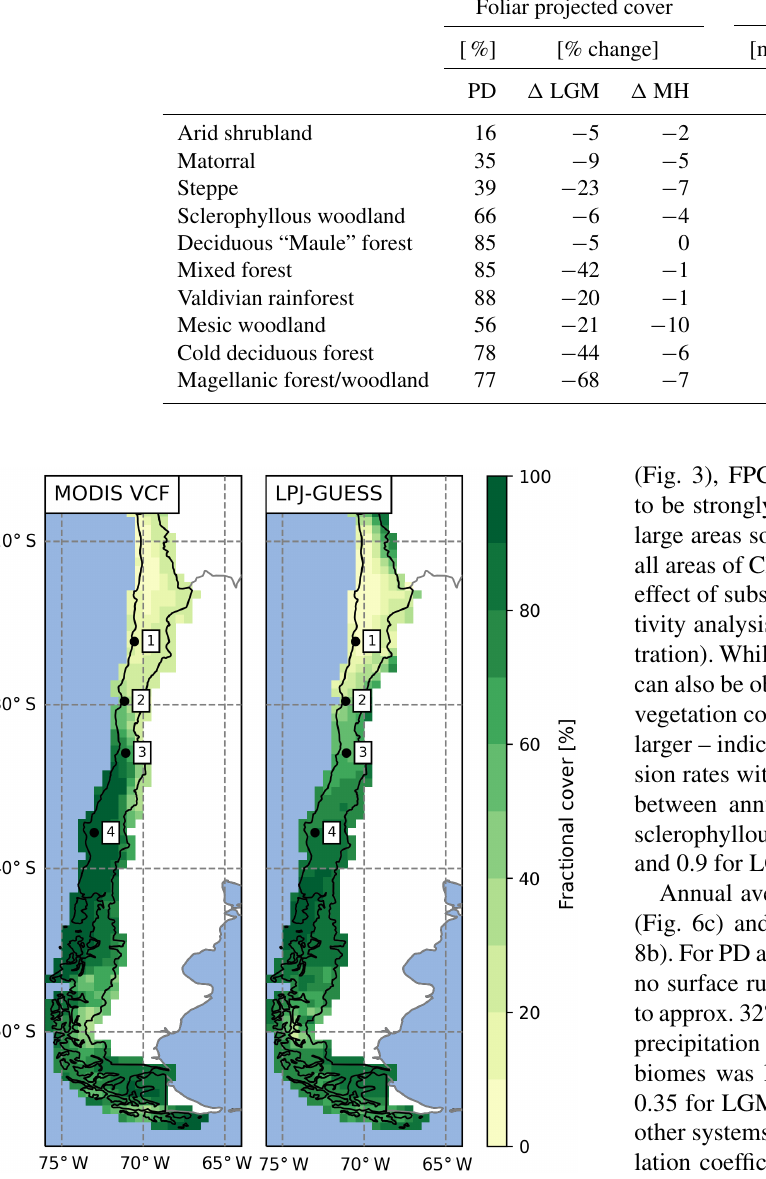
Figure 7. Comparison of satellite-derived vegetation cover and simulated average foliar projected cover of potential natural veg- etation for present day (data: MODIS MOD44B VCF v6, total veg- etation, 2001–2016 average; Dimiceli et al., 2017; 1 represents Pan de Azúcar, 2 represents Sta. Gracia, 3 represents La Campana, 4 represents